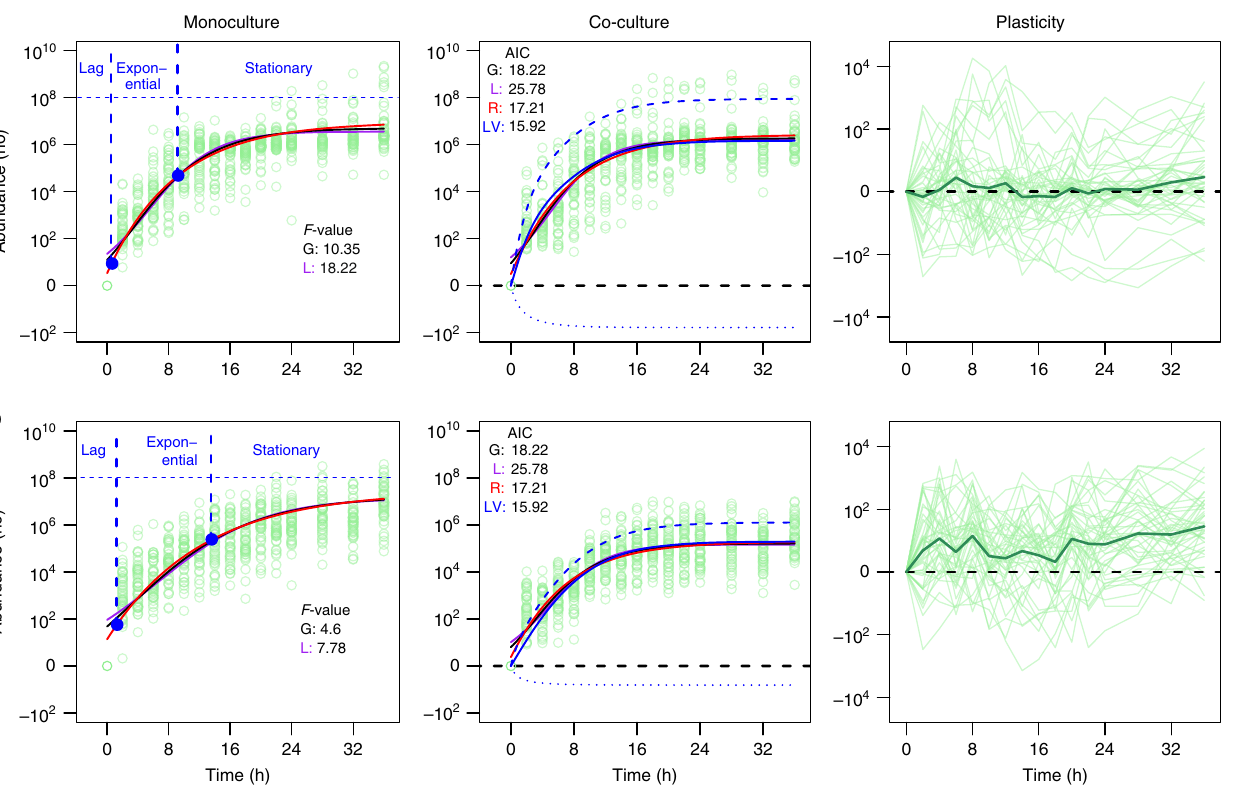
Fig. 1 Trajectories of microbial growth and its interaction-induced phenotypic plasticity for E. coli ( a ) and S. aureus ( b ). Microbial abundance of individual strains from each species (circles) was observed in monoculture and co-culture during the fi rst 36 h after culture. In monoculture, the F test of three- parameter Gompertz (G, green solid line) and logistic equations (L, red solid line) against the four-parameter Richards equation (R, blue solid line) suggests that the latter gives a better goodness-of- fi t to mean growth trajectories than the former two equations. Three distinct phases, lag, exponential, and stationary, on the Richards curve are indicated. In co-culture, the G, L, and R equations were compared with the Lokta – Volterra (LV) ordinary differential equations, suggesting that the LV is the most parsimonious according to the AIC values. The LV curve of each species in co-culture was partitioned into its underlying independent (broke line) and interactive growth components (dot line). Negative interactive growth for both species shows an antagonistic relationship held between E. coli ( a ) and S. aureus . Phenotypic plasticity curves were calculated as the differences of bacterial growth in monoculture from that in co-culture at different time points. Mean plasticity curves are indicated by thick